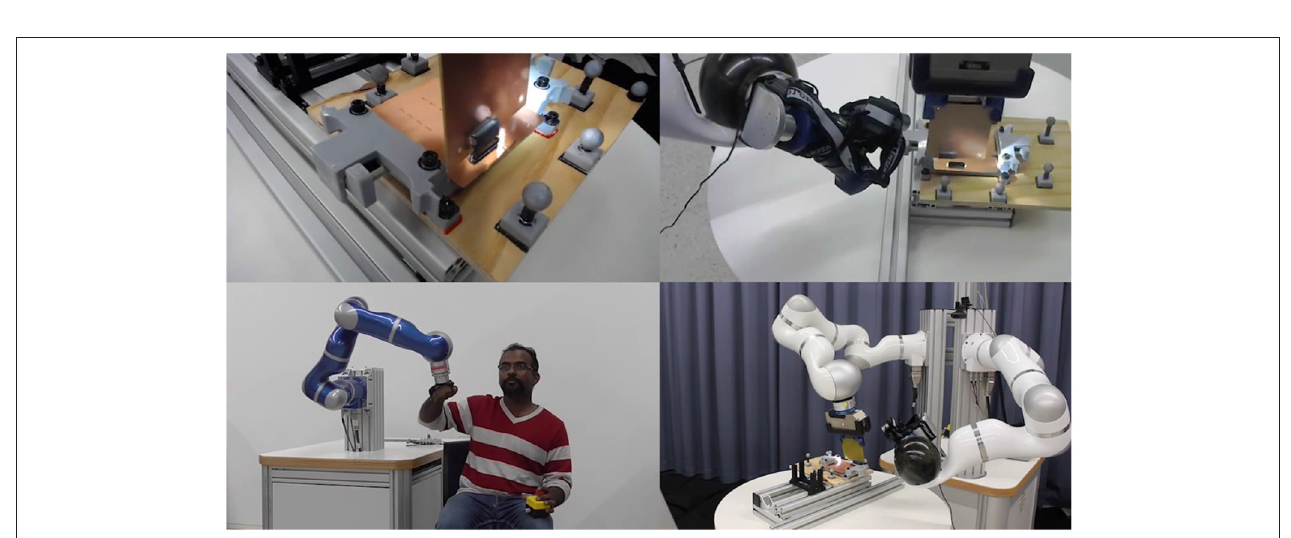
FIGURE 10 | Demonstration of a telerobotic high-precision assembly task of an electrical connector of CubeSats (Weber Martins et al.,